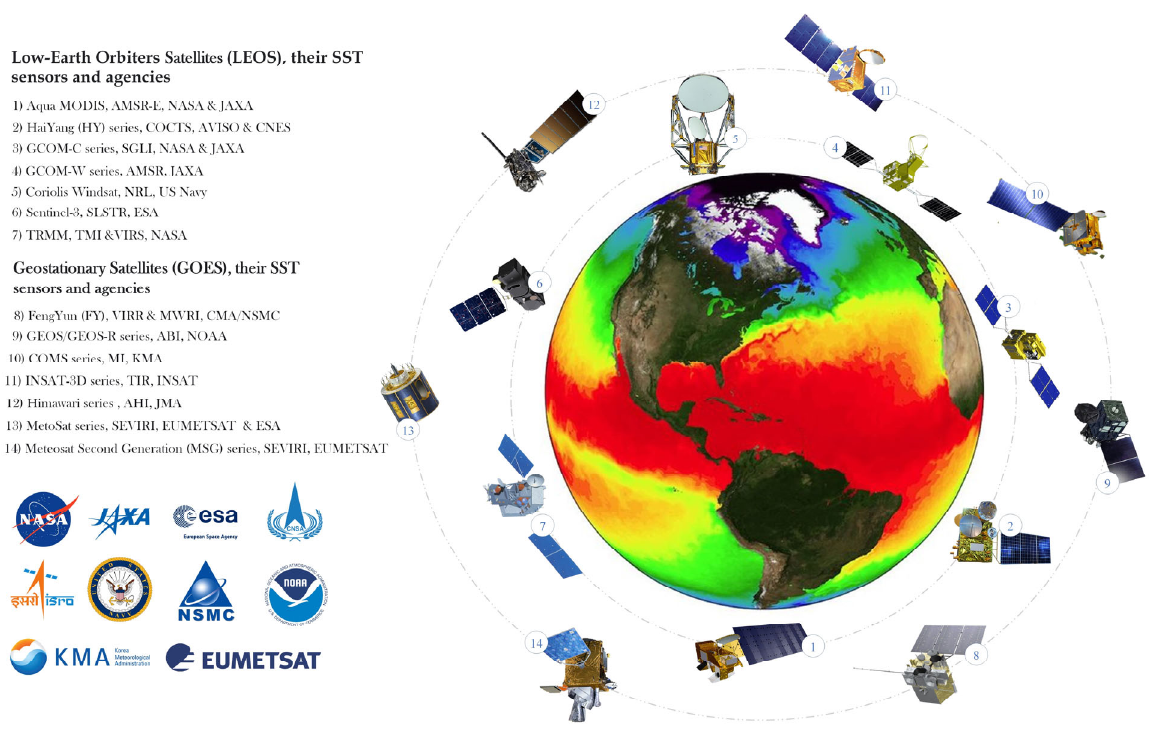
Figure 5. The main satellites for SST measurements.